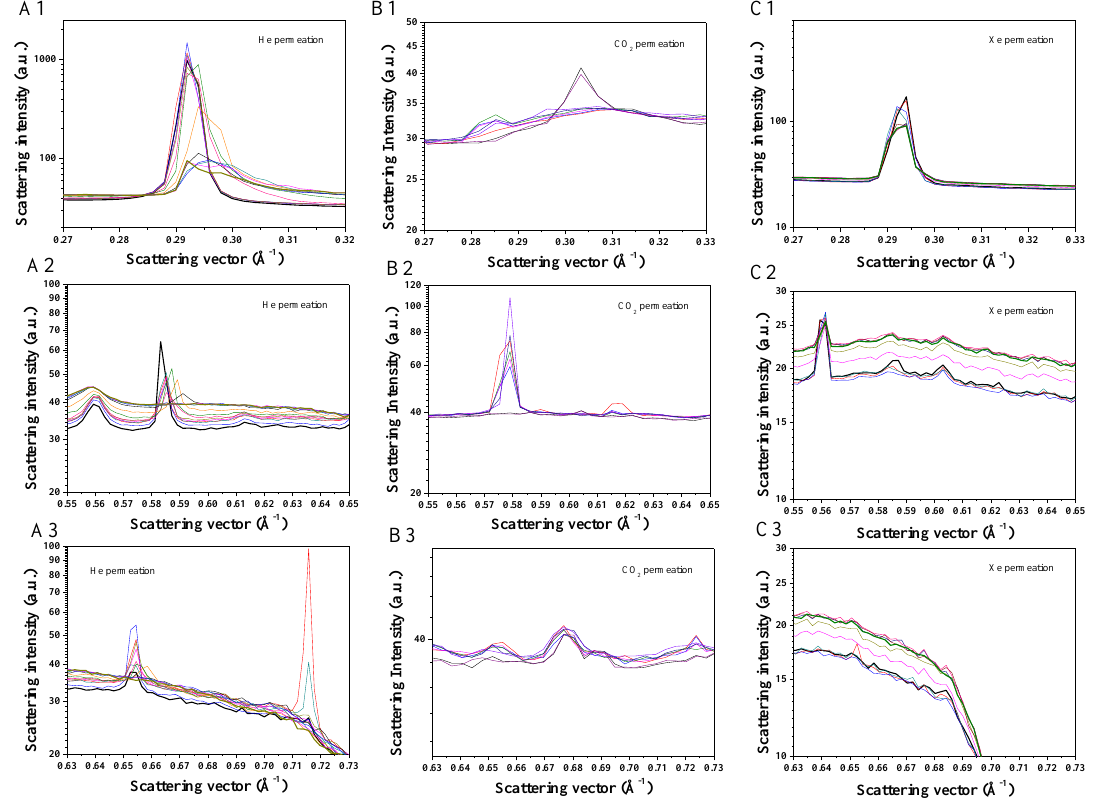
Figure A3. Examples of enlarged sections of the peaks discussed in Figure 3 for clarity of the shifts and intensity attenuations for the He, CO 2 , and Xe gases for the windows 0.27–0.33, 0.55–0.65, and 0.63–0.73 Å −1 .